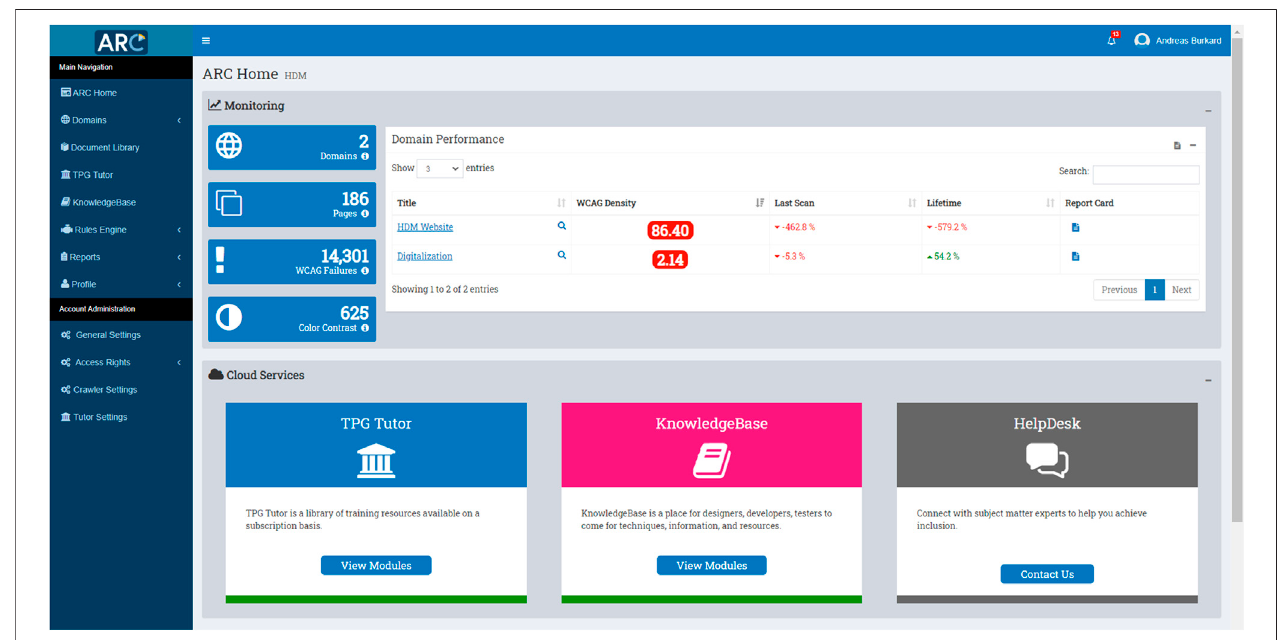
FIGURE 4 | ARC Monitoring dashboard.